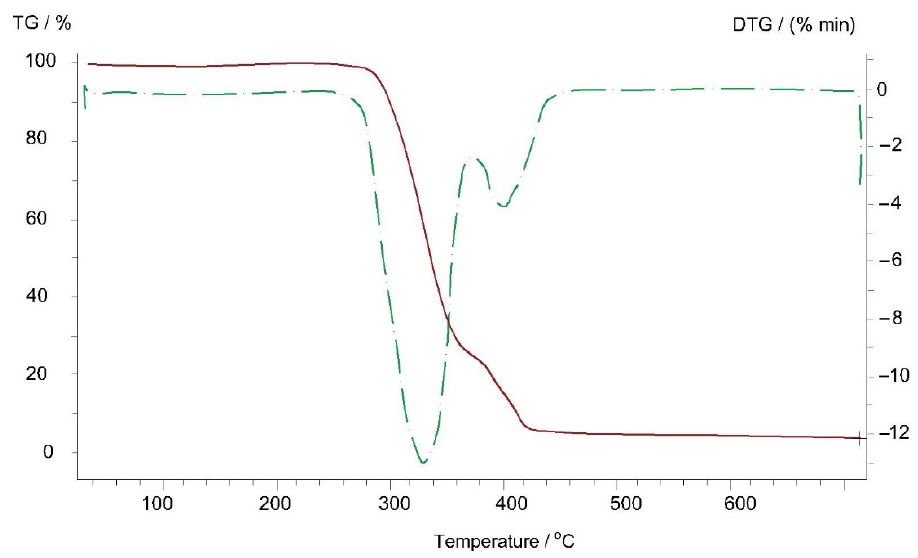
Figure 9. Thermogravimetric curve of the Arbofill ® Fichte sample.